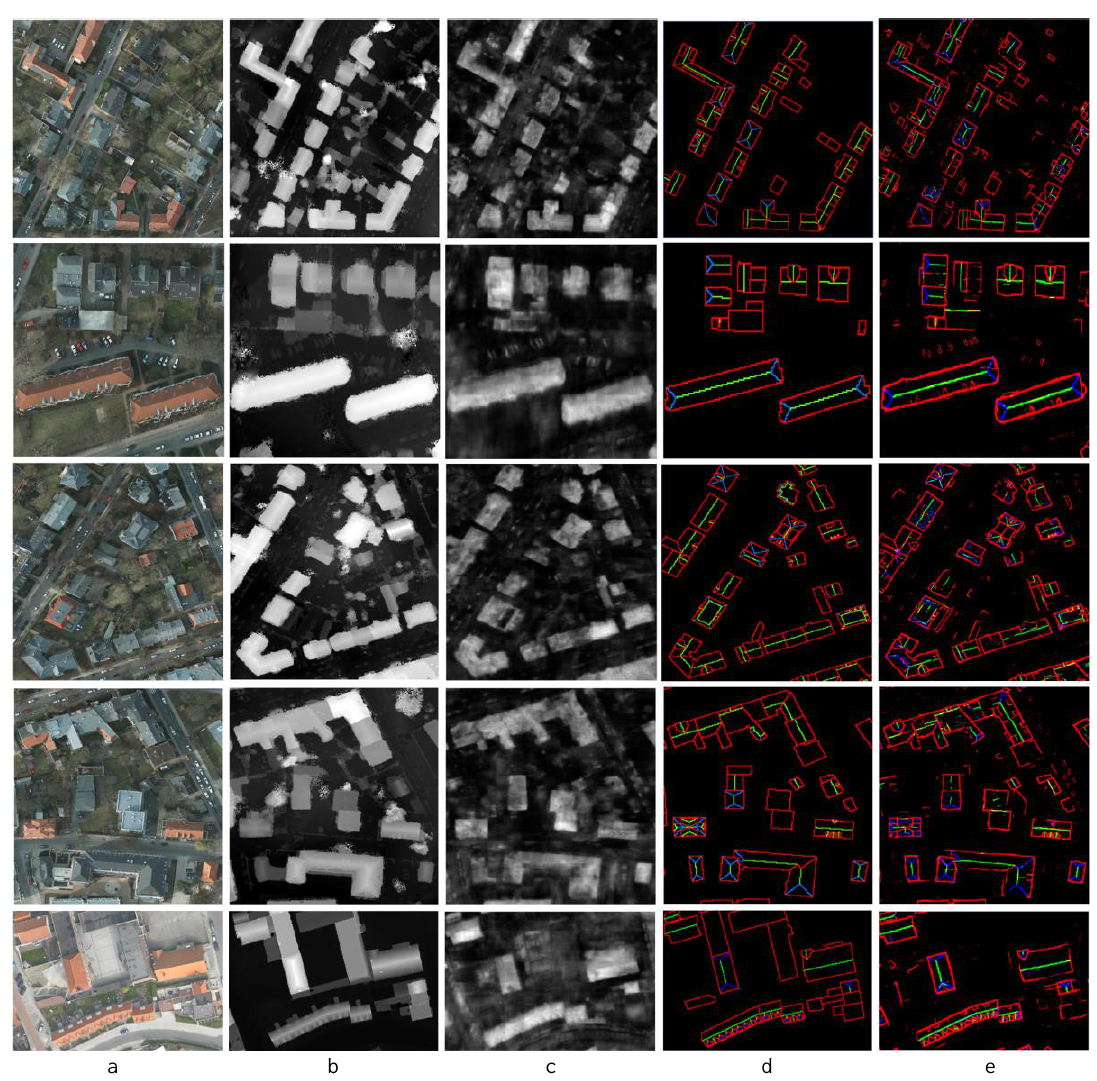
Figure 8. The results of the predicted nDSMs and rooflines: a: the input RGB images from two test datasets; b: the reference nDSMs; c: the predicted nDSMs; d: the reference rooflines; e: the predicted